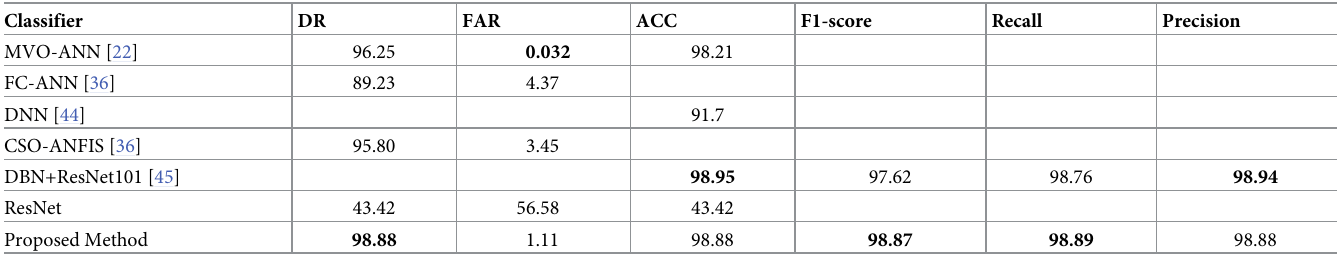
Table 7. Detection rate, ACC, and FAR comparison of different classifiers on KDDTrain+.